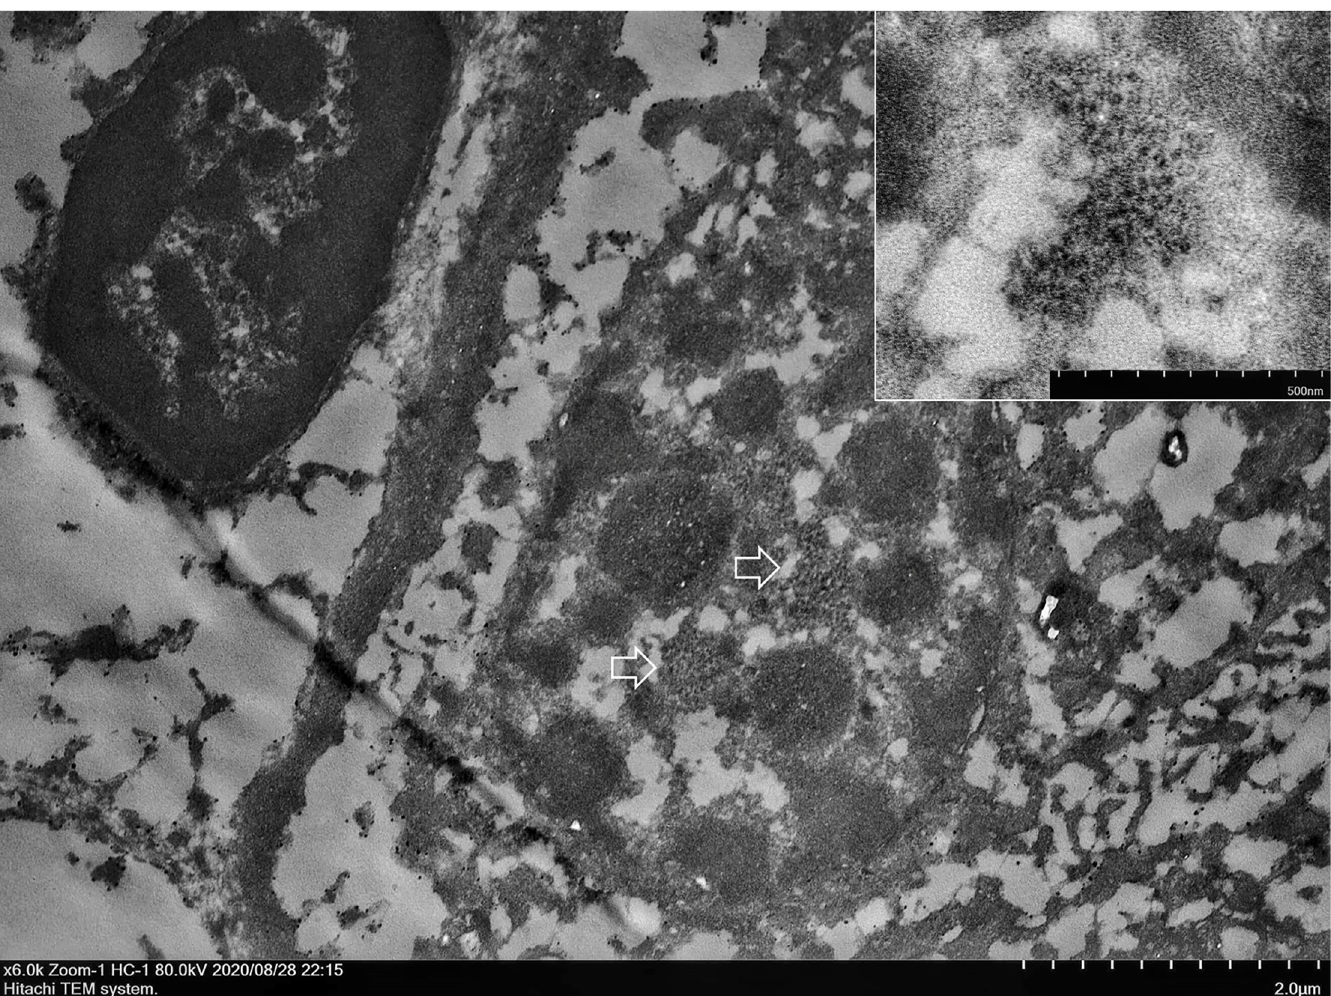
Fig 3. CPPV-1 viral particles in the nucleus of renal tubular epithelial cells. Transmission electron microscopy (TEM) using the pop-off technique. Ultrastructural demonstration of clustering of electron-dense particles (arrows). The icosahedral particle size was 19–22 nm diameter located in the nucleus of renal tubular epithelial cells (inset). Scale bars as shown in the